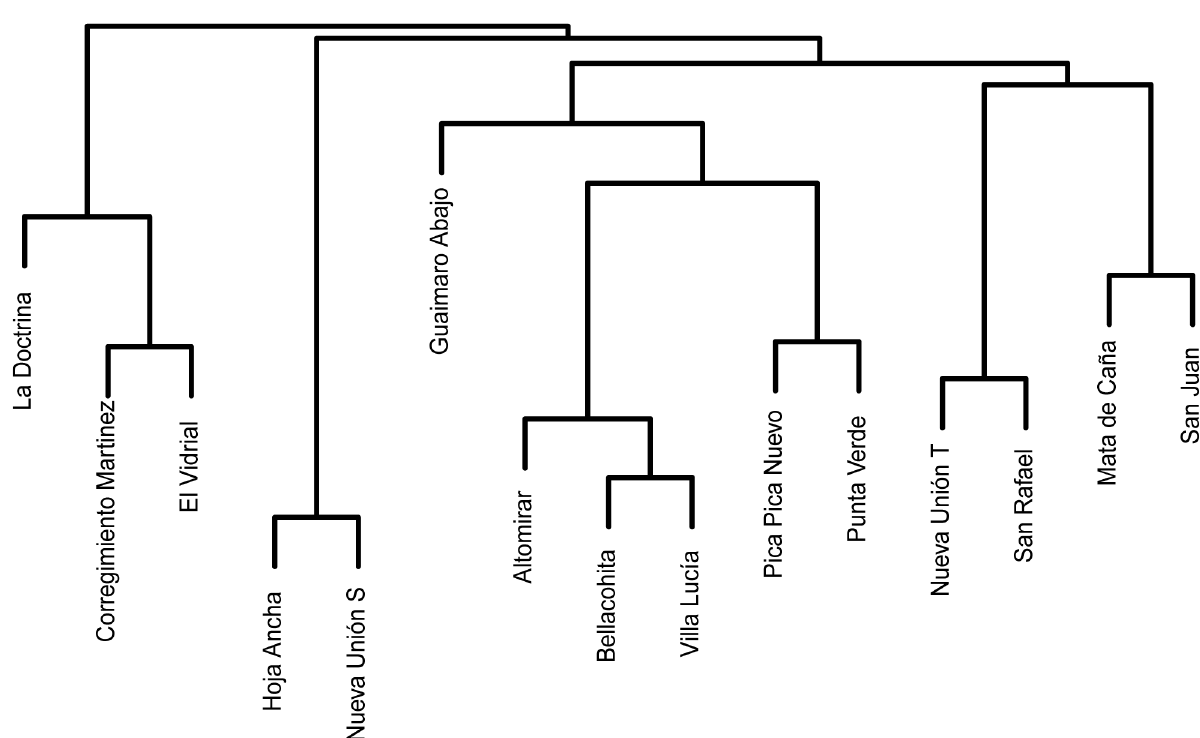
Fig 3. Cluster dendrogram showing similarity of sand-fly community composition of the sampled towns in Cordoba, Colombia. The dendrogram is based on a Bray-Curtis distance with towns clustered together having communities more similar to each other than to other towns. For this dendrogram, sandflies from all houses in a single sampled town were grouped irrespective of wether they were sampled intra or peridomicilary.